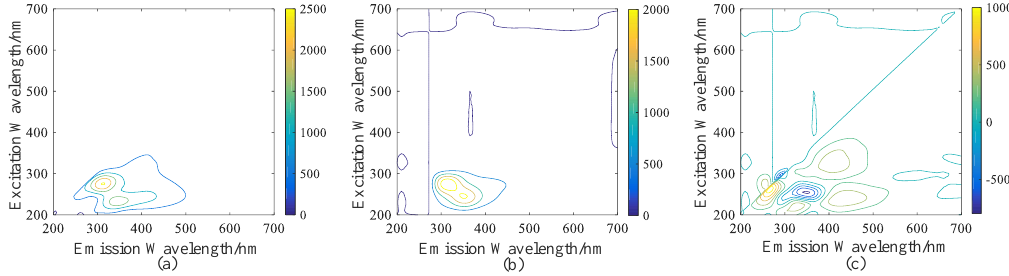
Figure 12. ( a ) Measured values; ( b ) modeling values; and ( c ) residual matrix of drinking water based on ATLD.